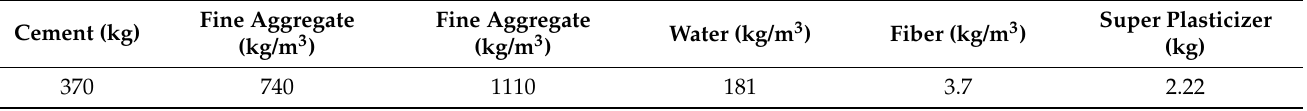
Table 5. Mix proportion quantities.